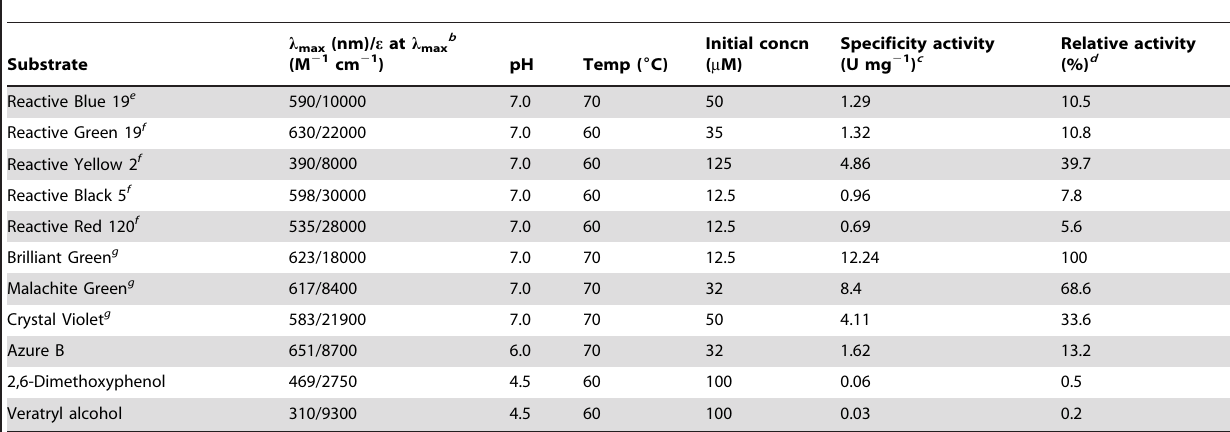
Table 2. Enzymatic activity of purified Svi DyP towards various dyes a